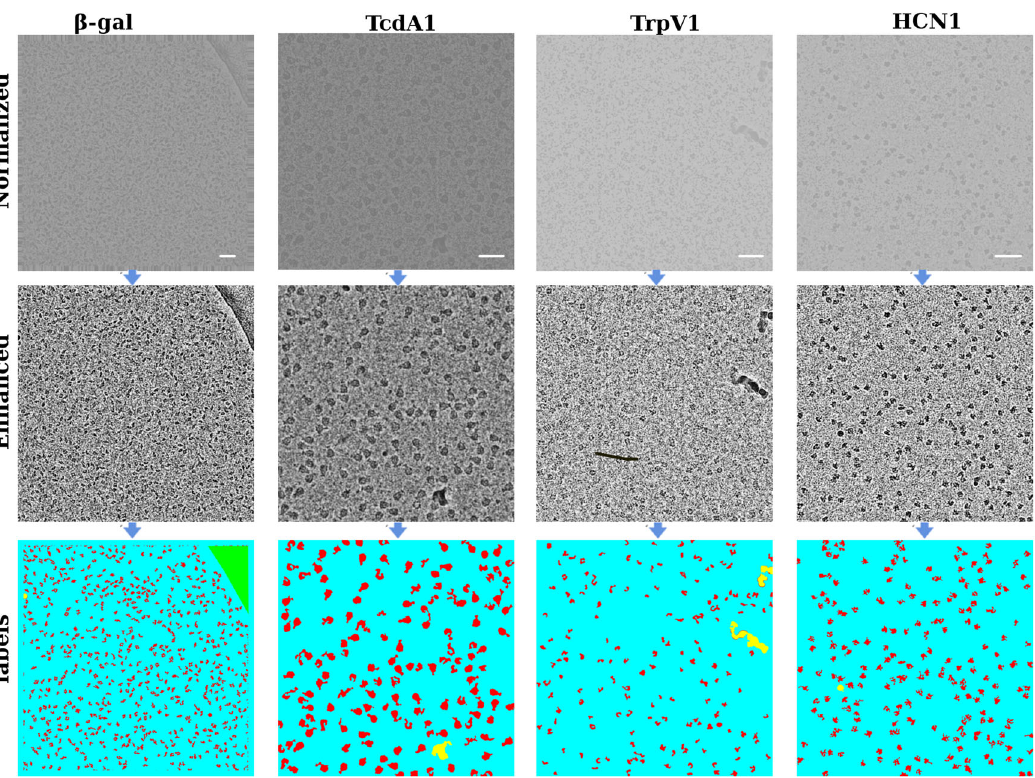
Fig. 2 From raw to semantically segmented micrographs. The raw micrographs, contrast enhanced and semantically segmented images of micrographs from β -galactosidase (EMPIAR 10017), TcdA1 (EMPIAR 10189), TRPV1 (EMPIAR 10005), and HCN1 (EMPIAR 10081), respectively. The entire micrograph is segmented into different classes and each class is represented by a unique color. The background, protein, ice contamination, and carbon contamination are represented using cyan, red, yellow, and green colors, respectively. Scale bar is set at 50